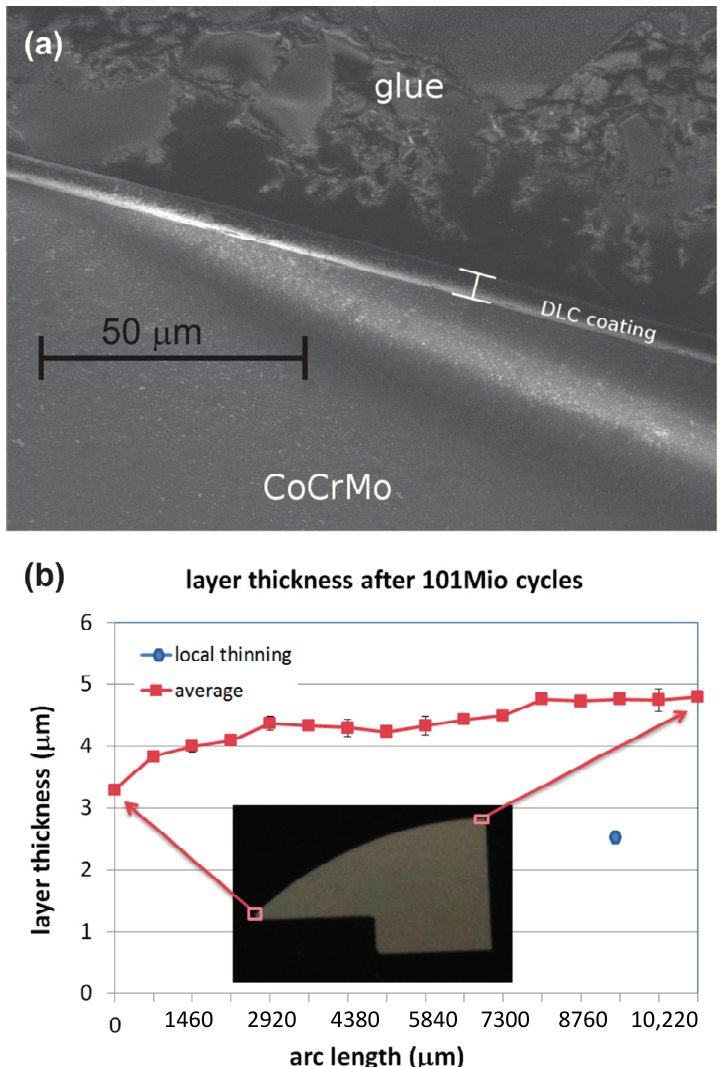
Figure 3. ( a ) SEM (scanning electron microscopy) image of cross-section of the convex implant after 100 million cycles; ( b ) Resulting layer thickness distribution derived from the cross